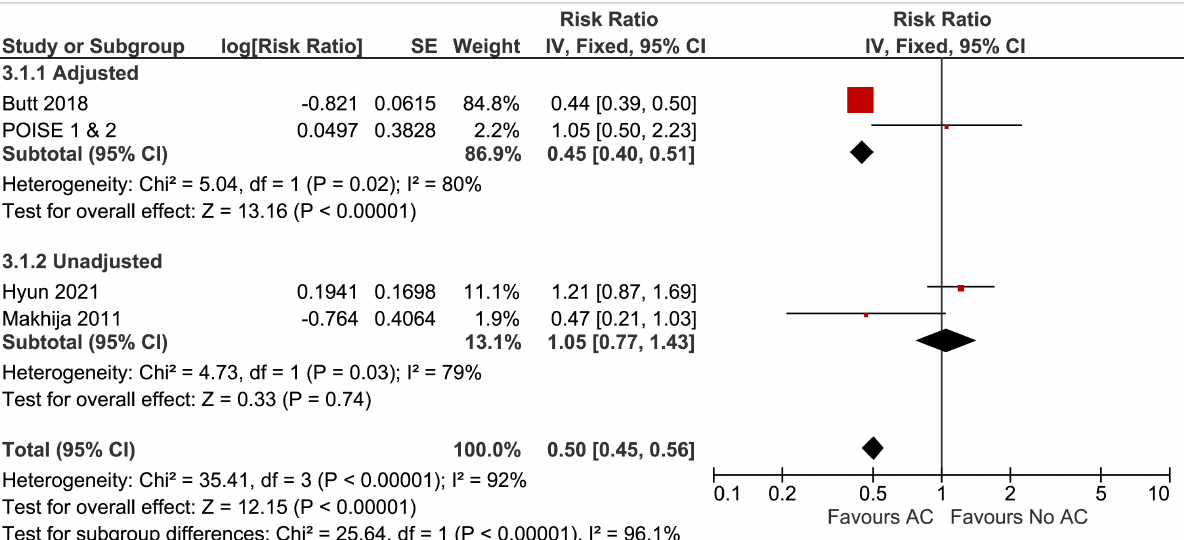
Supplemental figure S2. Forest plot for mortality, stratified by use of multivariable